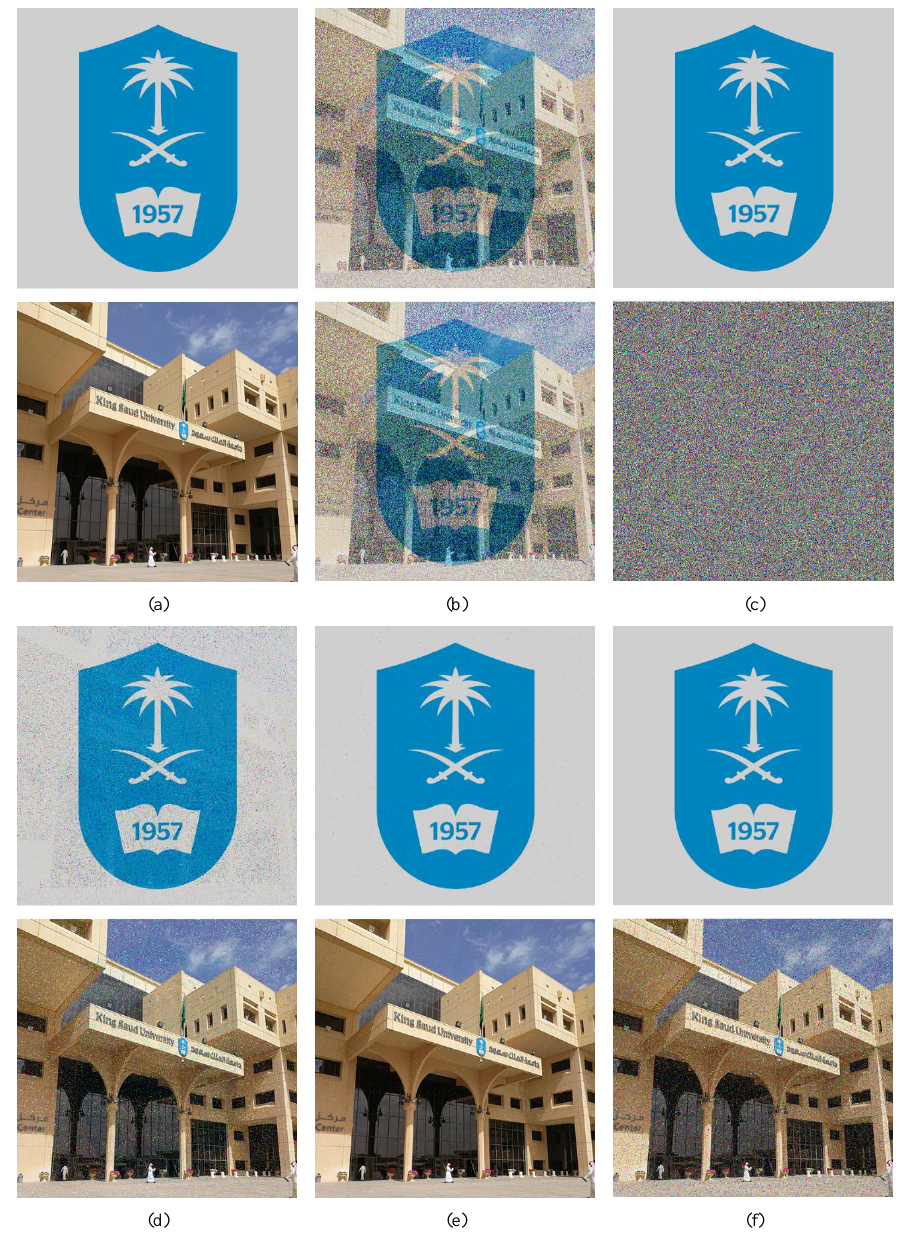
Figure 15. The impact of multi-user interference on the received images. The top row images are for u 1 and the second-row images are for u 2 . ( a ) Transmitted images. ( b – f ) Received images